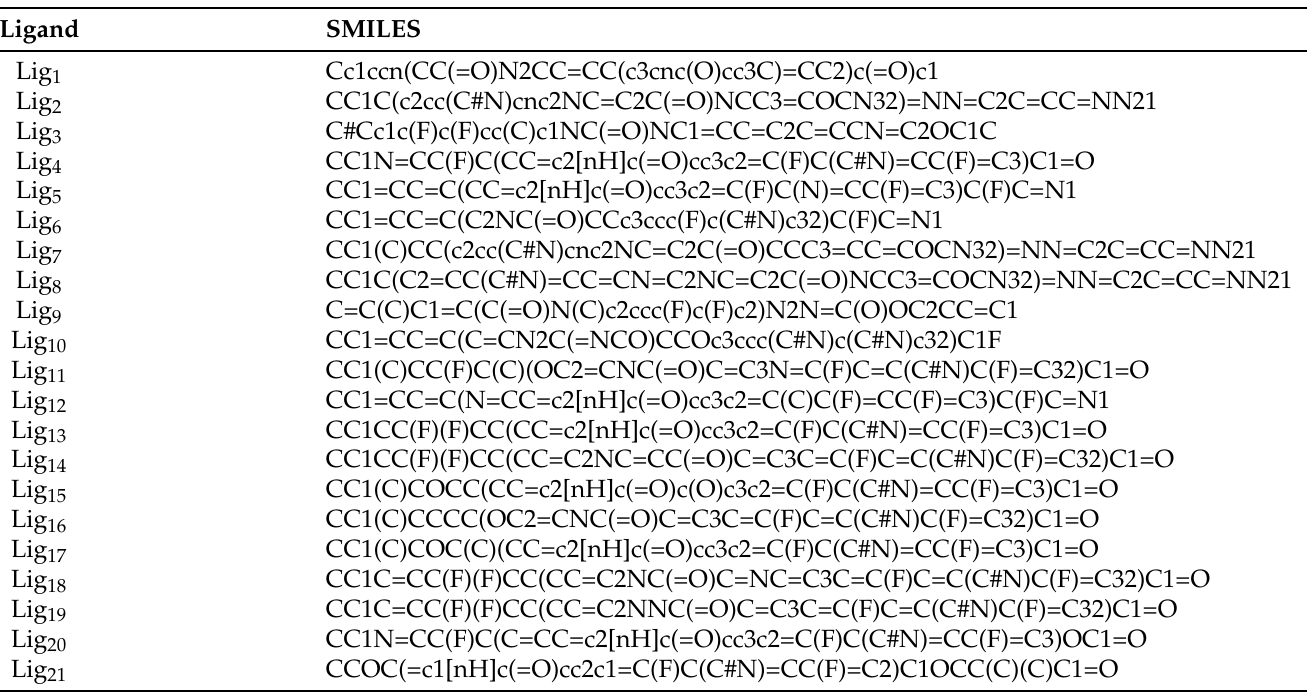
Table A1. Overview of the 21 ligands with their SMILES representation.